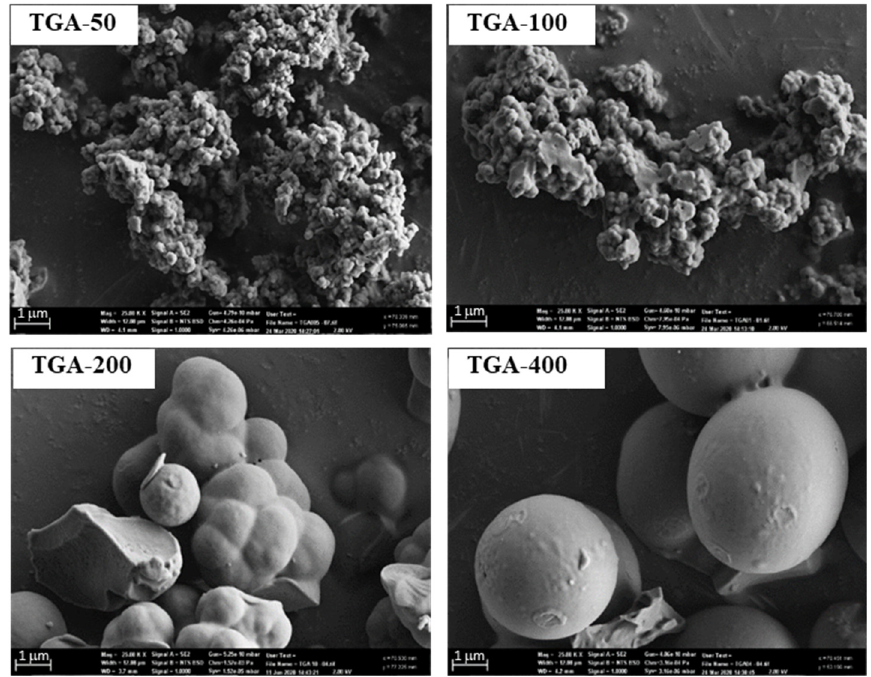
Figure 1. SEM images at 2k magnification of TGA-MIPs produced from different amounts of